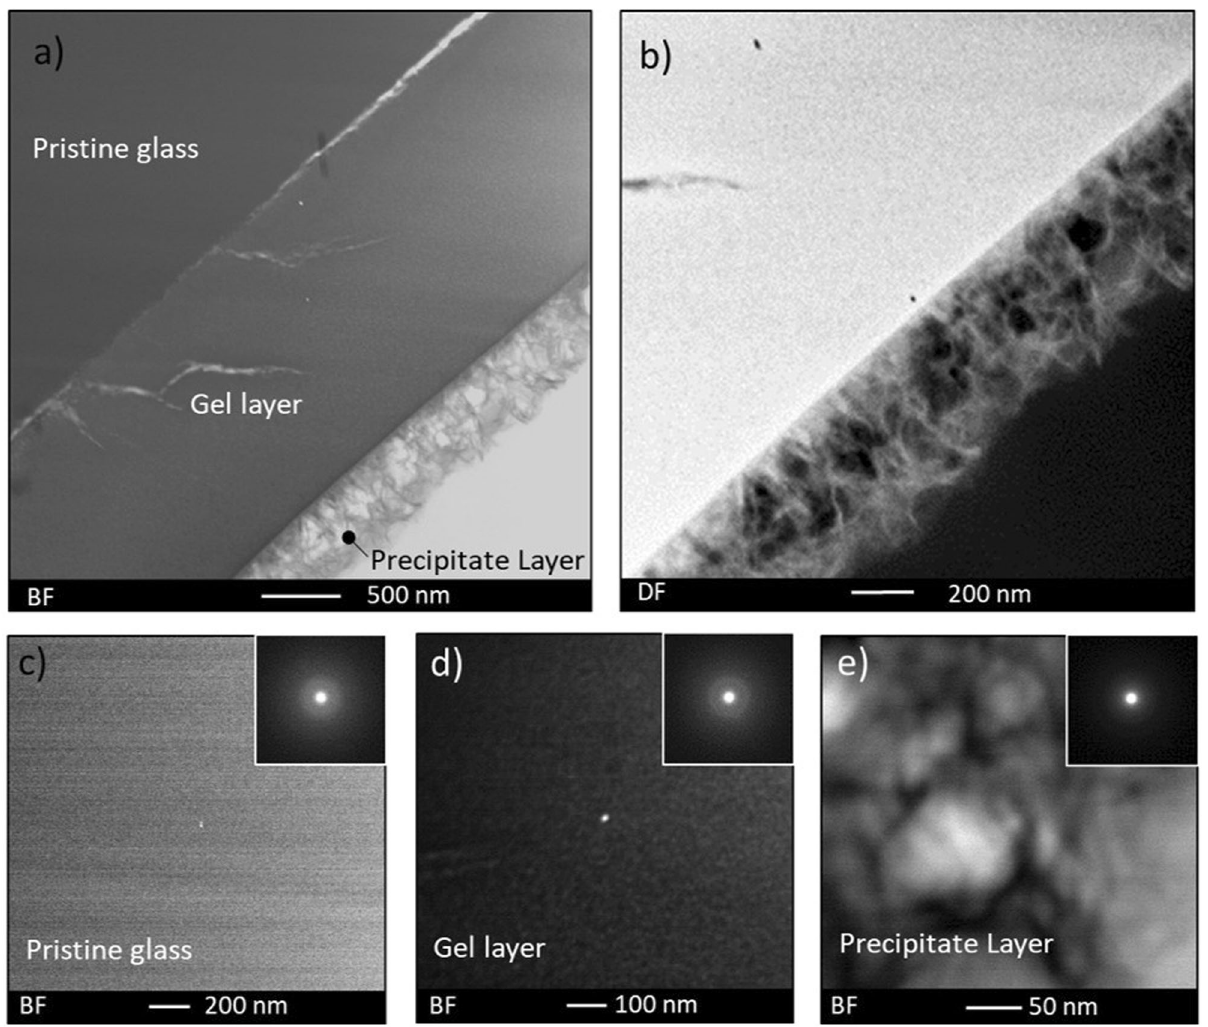
Fig. 2 Scanning transmission electron microscopy analysis of CaZn28 glass after 84 d of dissolution in Young Cement Water. a Image showing the cross section of the pristine glass, gel layer and precipitate layer; ( b ) dark fi eld micrograph of the gel layer and Mg-silicate rich ribbon precipitates; and high resolution bright fi eld images and associated selective area electron diffraction patterns of: ( c ) the pristine glass; ( d ) the gel layer; and ( e ) the